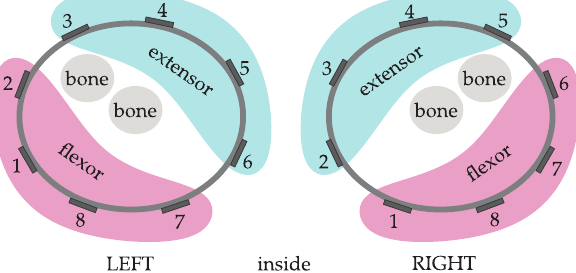
Figure 4. Muscles inside the forearm with the consequent electrodes numbers of EMG